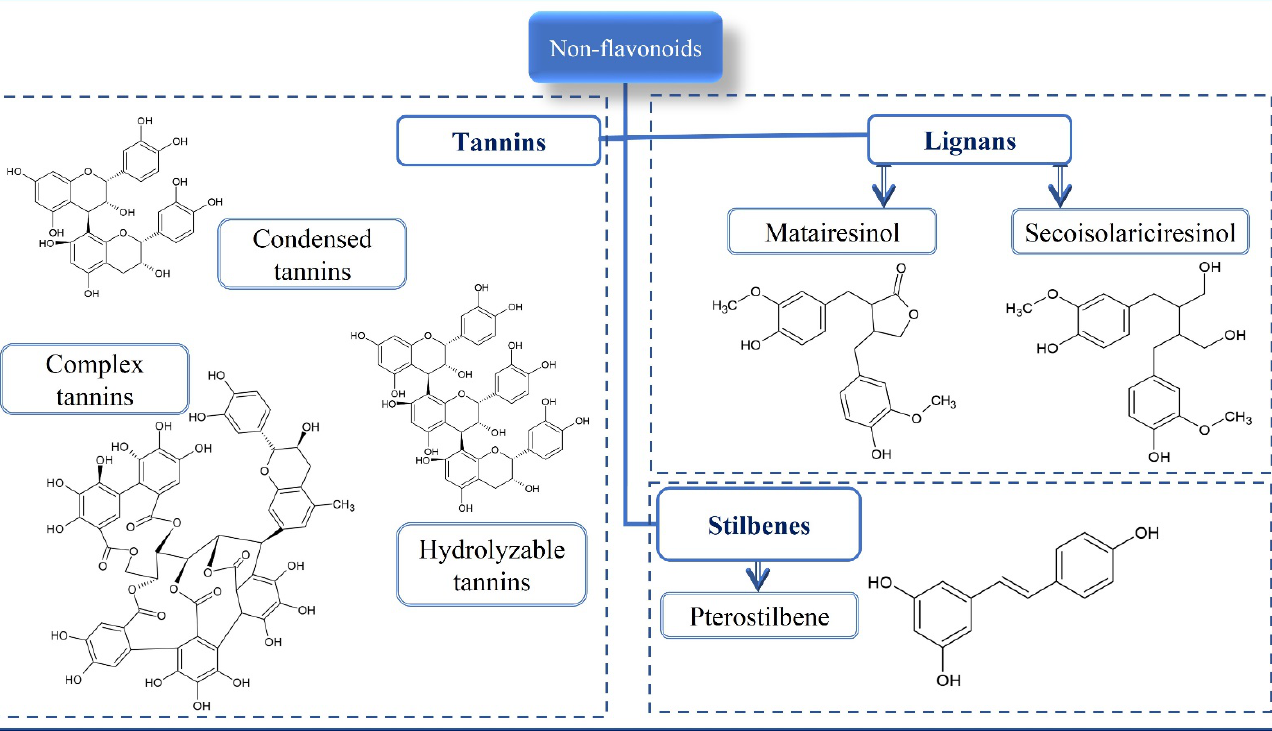
Figure 3. Chemical structure of main non-flavonoids found in cereals and pseudocereals.